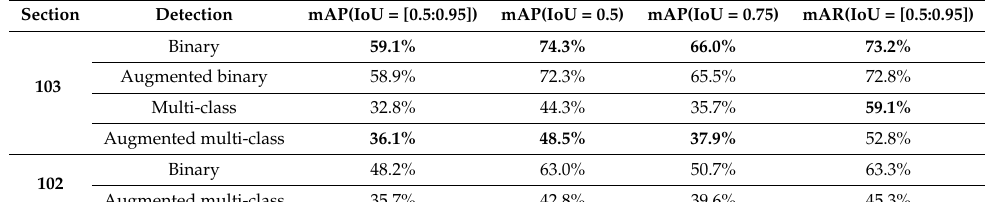
Table 5. Evaluation metrics for binary and multi-class object detection.